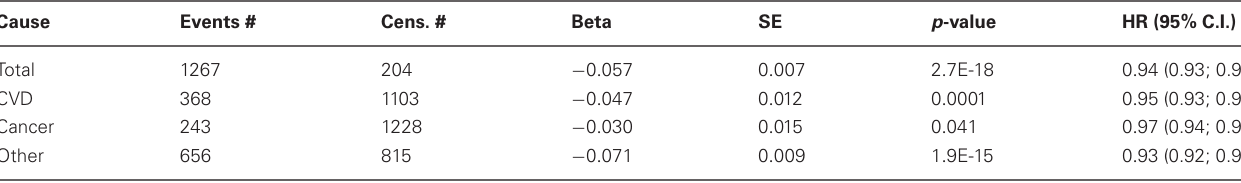
Table 3 | Effects of polygenic score on total and cause-specific mortality in the Cox model. Cause Events # Cens. # Beta SE p -value HR (95%